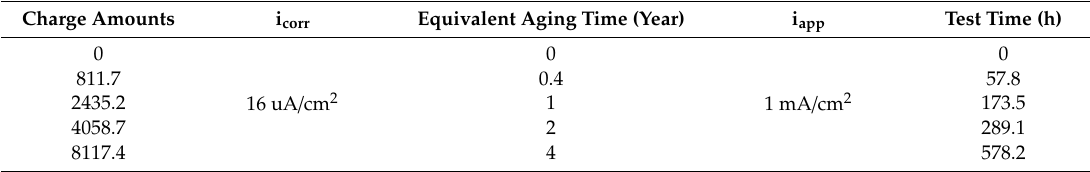
Table 6. Conditions of the galvanostatic test (S = 3.9 cm 2 ).